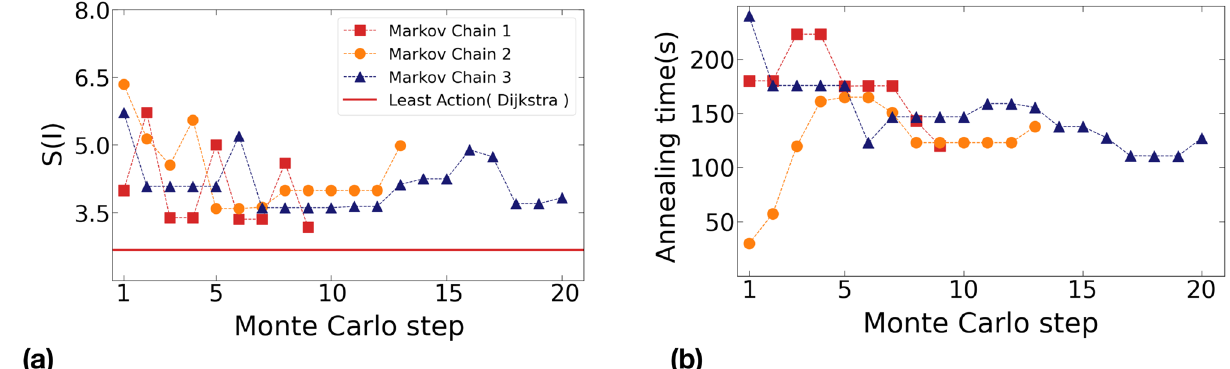
Figure 3. (a) Evolution of the path action S ( I ) and (b) annealing time t sweep along the Monte Carlo paths generated using the hybrid classical/quantum annealing implemented on